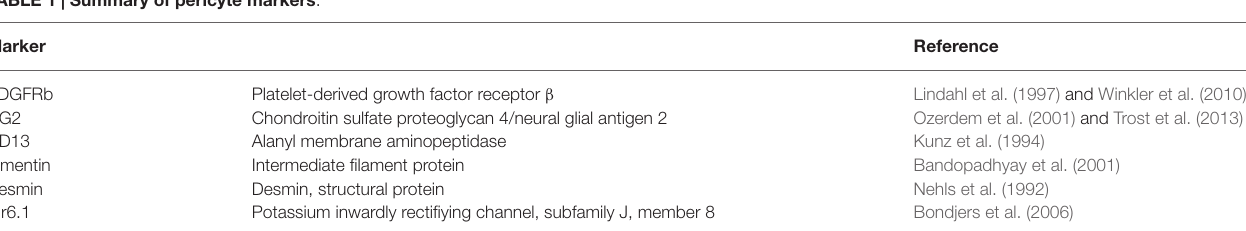
TABLE 1 | Summary of pericyte markers